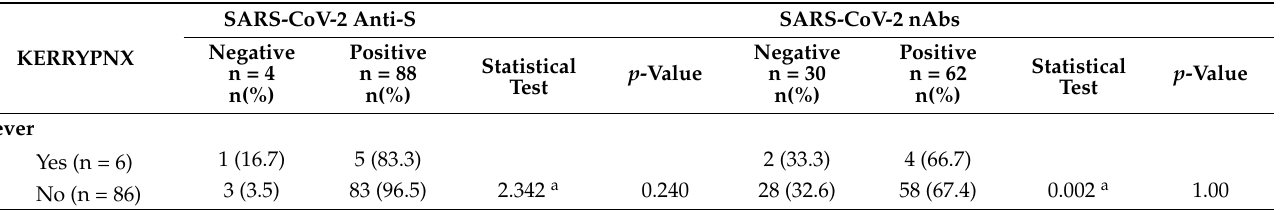
Table 9. Testing the association between the seroprevalence of SARS-CoV-2 anti-S and nAbs and short-term adverse reactions after Sinopharm COVID-19